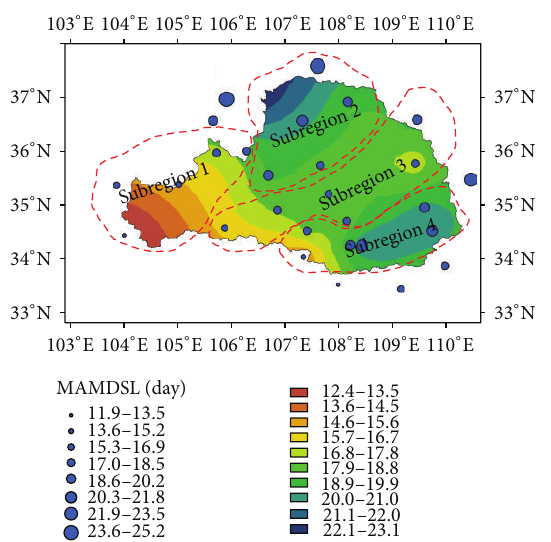
Figure 6: The spatial variation of MAMDSL in the WRB.